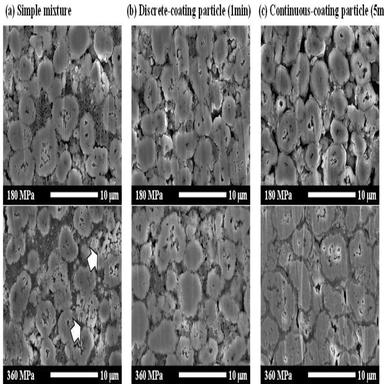
Cross-section SEM image of cathode pellets prepared with (a) simple mixture, (b) discrete-coating particles, and (c) continuous-coating particles at different pressures. The white arrows indicate the breakage of NCM particles.